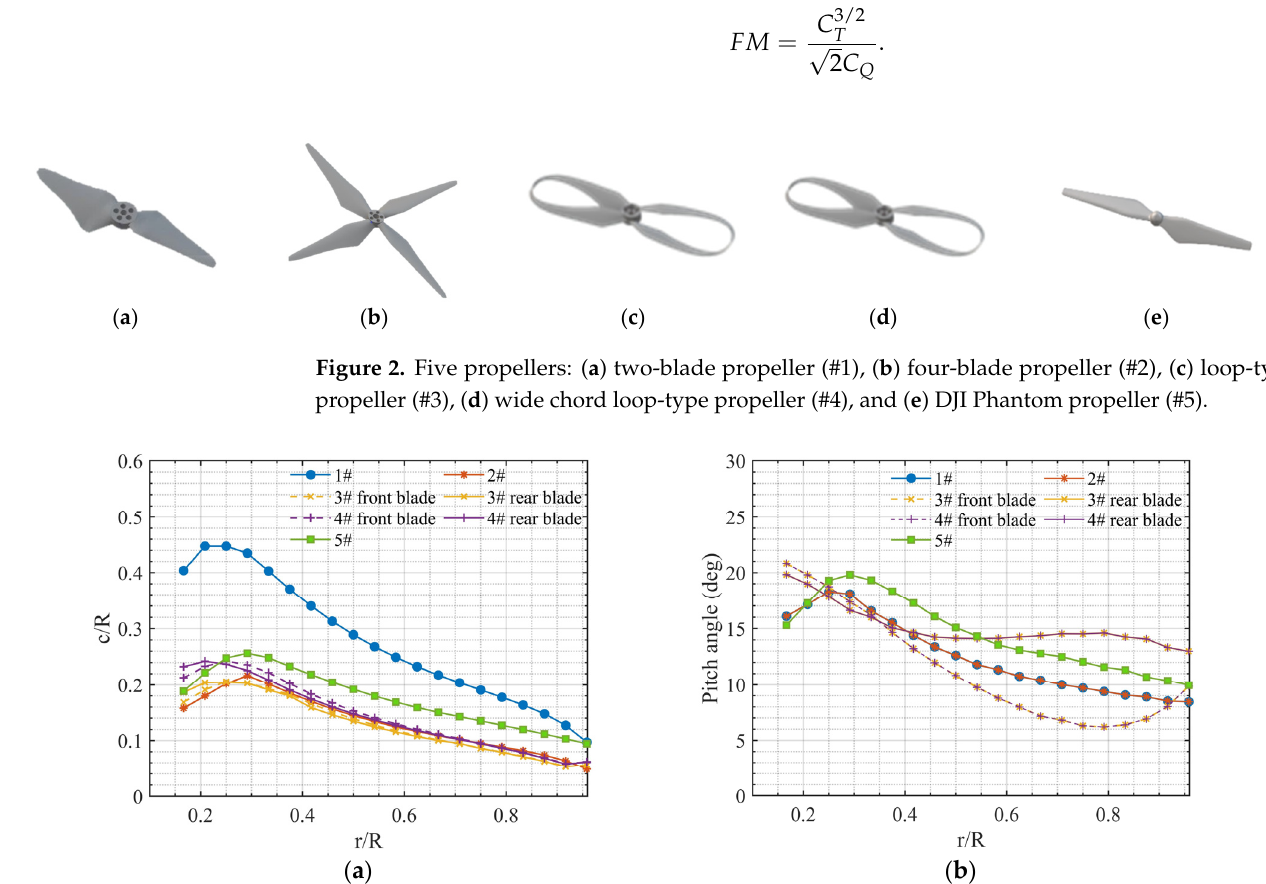
Figure 3. Radial distributions of chord length ( a ) and pitch angle ( b ) of five propellers.